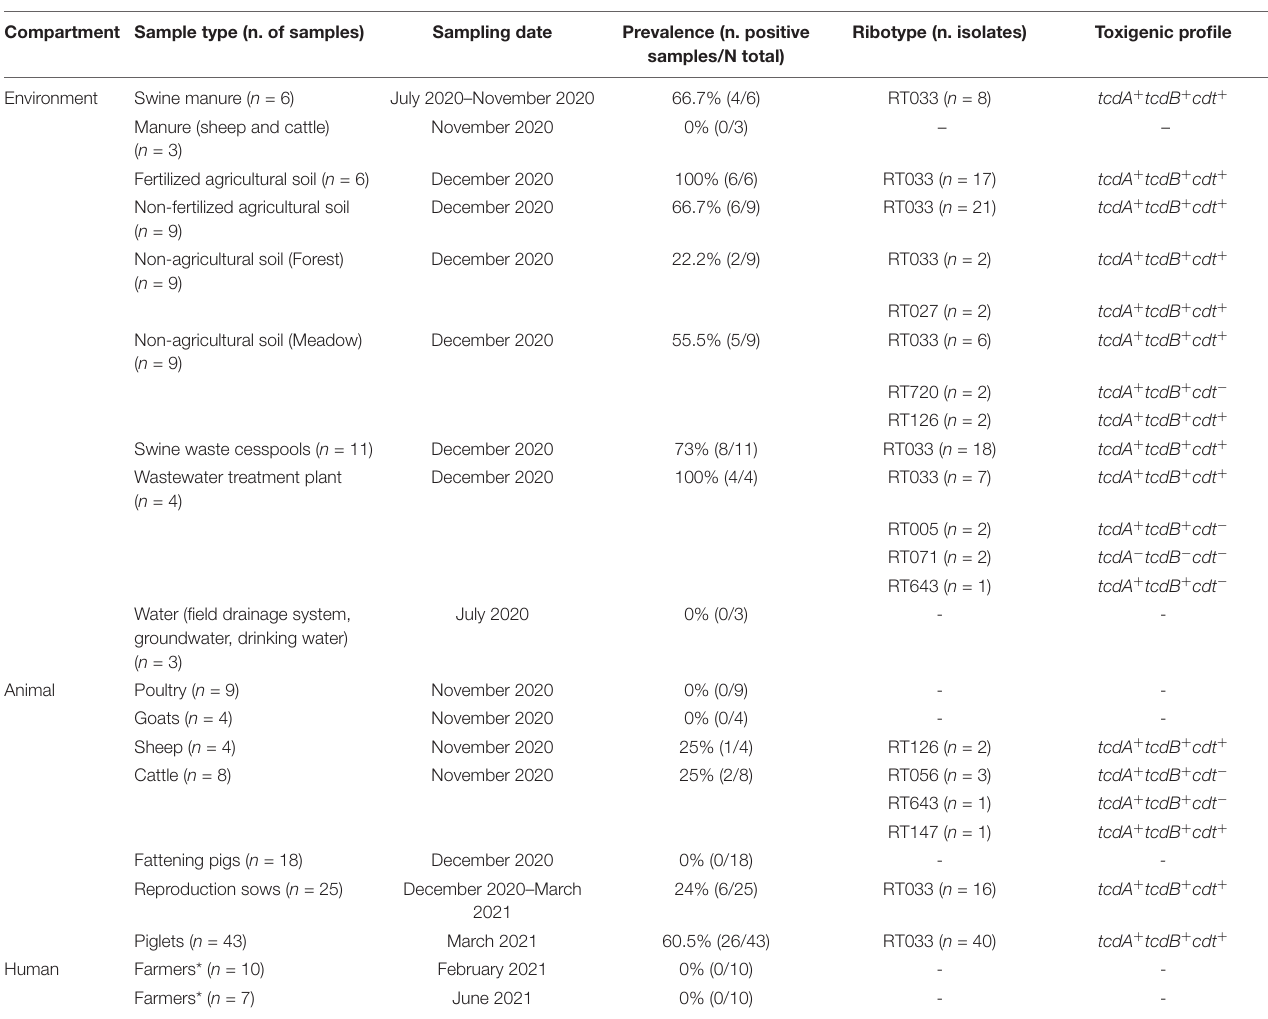
TABLE 1 | Description of the samples analysed in the several compartments of the pig production unit and main findings. Compartment Sample type (n. of